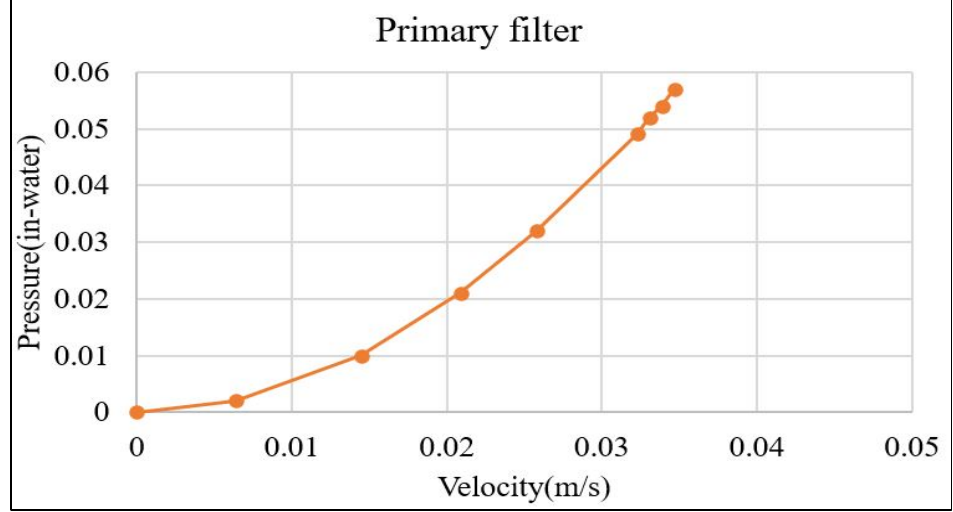
Figure 17. P-Q curve of the chemical filter screen.